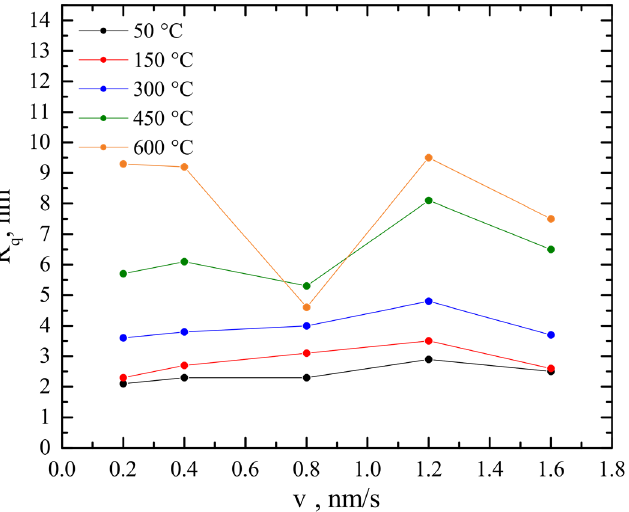
Figure 4. Roughness dependence of ScAlSZ thin films on deposition rate at different substrate temperatures during the deposition.